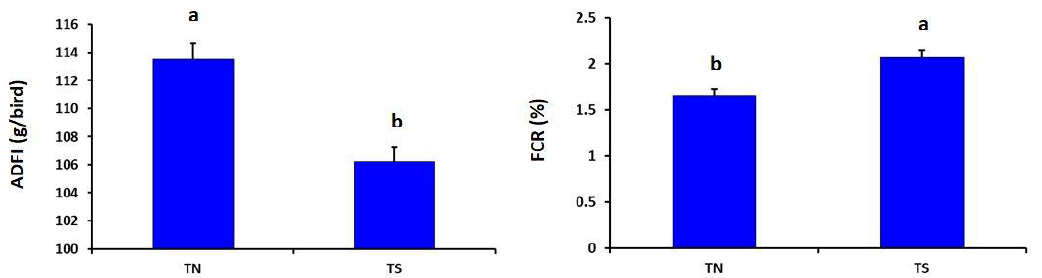
Figure 1. Effects of chronic thermal stress on average daily feed intake (ADFI) and feed conversion ratio (FCR) of broiler chickens ( p = 0.030 and 0.041, respectively). TN: Thermoneutral group; TS: Thermal-stressed group. a,b Values with different superscripts differ significantly.